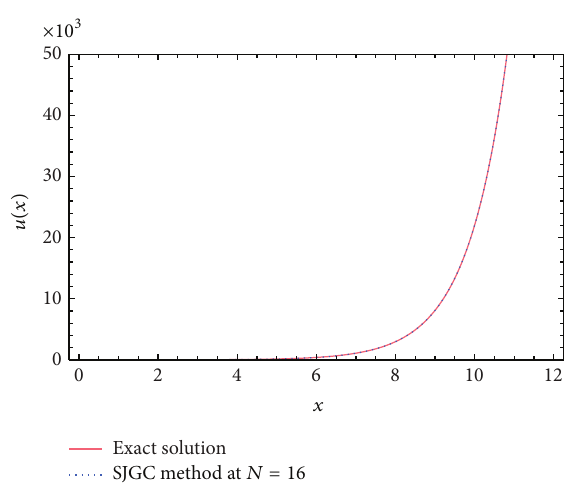
Figure 2: Graph of exact solution and approximate solution for ] = 𝜇 = 1/2 at 𝑁 = 16 for Example